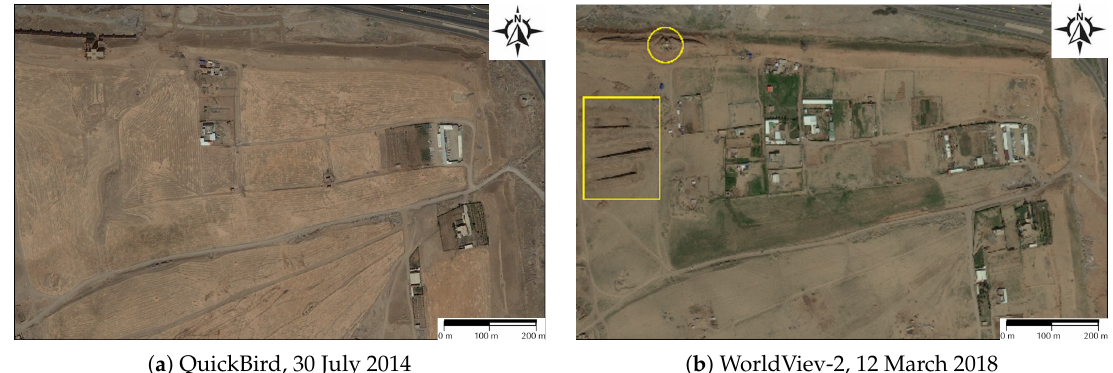
Figure 6. Construction damage type related to uncontrolled construction activities. Trenches affecting buried heritage have been opened and new buildings have been constructed over cultural heritage site (highlighted in yellow) c (cid:13)